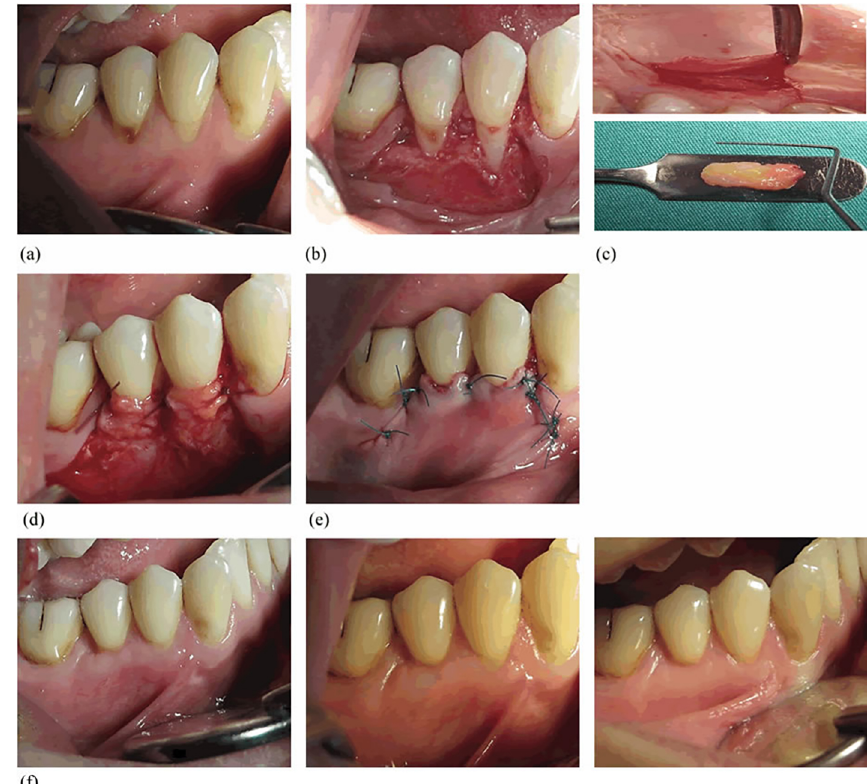
Figure 3- Control group. (a) Preoperative view. (b) Flap design and vertical incisions. (c) Palatinal area. (d) CTG placement. (e) CAF and sutures. (f) First, third and sixth months postoperative view. CTG. connective tissue graft; CAF. coronally advanced